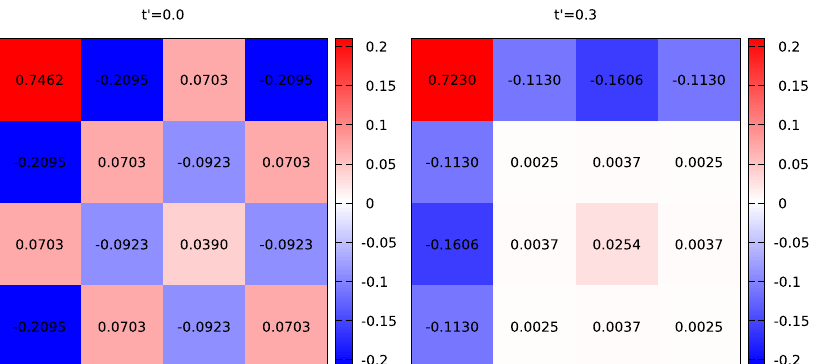
Fig. 3 Spatial spin correlation. Static spin-spin correlation function 〈 M 0 M i 〉 obtained by exact diagonalization for the ground state of the sector (7 ↑ , 7 ↓ ) of the 4 × 4 cluster for U = 5.56 and different t 0 . Whereas t 0 ¼ 0 features clear antiferromagnetic correlations, at t 0 = t ¼ (cid:1) 0 : 3 these are replaced by stripe-like ferromagnetic correlations. The top-left corner corresponds to i =